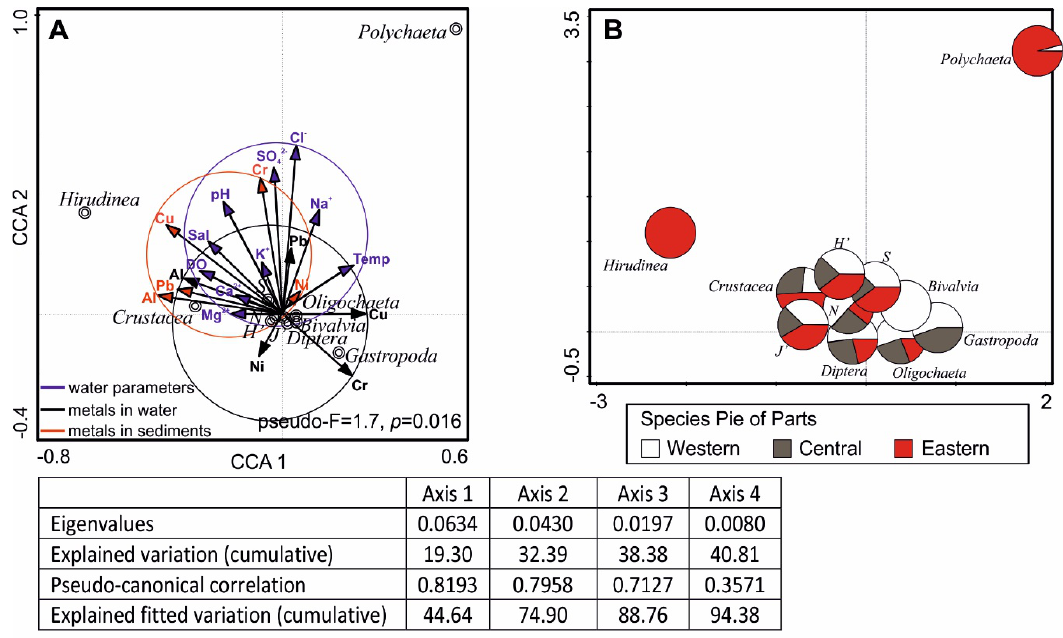
Figure 3. ( A ) Ordination analysis CCA of macrofauna and environmental variables (physico-chemical variables of water, heavy metals in water and sediments) on the principal component 1 and 2; ( B ) pie diagrams based on values of biological descriptors and density of invertebrates groups in parts of lakes. Descriptors: H ′ = Shannon diversity; J ’ = Pielou evenness; S = number of species; N = macrofauna total density; and environmental variables: Temp. = temperature; pH = water reaction; Sal = salinity; DO = dissolved oxygen; Cl − = chlorides; SO 42 − = sulphates; Na + = sodium; Ca 2+ = calcium; Mg 2+ = magnesium.